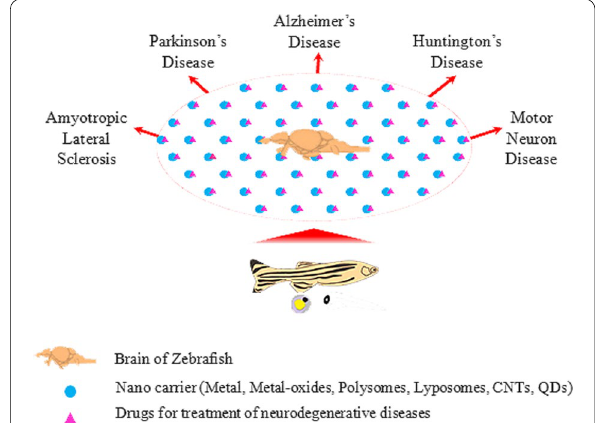
Fig. 2 Schematic representation of zebrafish model for delivering drugs encapsulated in nanoparticles to the brain. This method ensures efficient delivery of drugs across the blood–brain barrier (BBB). Several nanoparticles possess the potential to treat a variety of neurodegenerative diseases like Alzheimer’s disease (AD), Parkinson’s disease (PD), Huntington’s disease (HD), amyotrophic lateral sclerosis (ALS) and motor neuron diseases